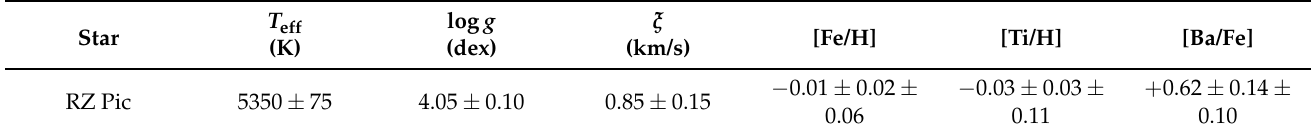
Figure 2. Comparison between observed and synthetic profiles calculated by adopting the atmo- spheric models by Punzi et al., 2018. Several strong iron and nickel lines are labelled. The value of V t = 2 km s − 1 is too large to successfully reproduce the observed line profiles. Table 1. Results of our analysis for RZ Pic. Errors on abundances include EW/spectral synthesis uncertainties ( σ 1) and errors on stellar parameters ( σ